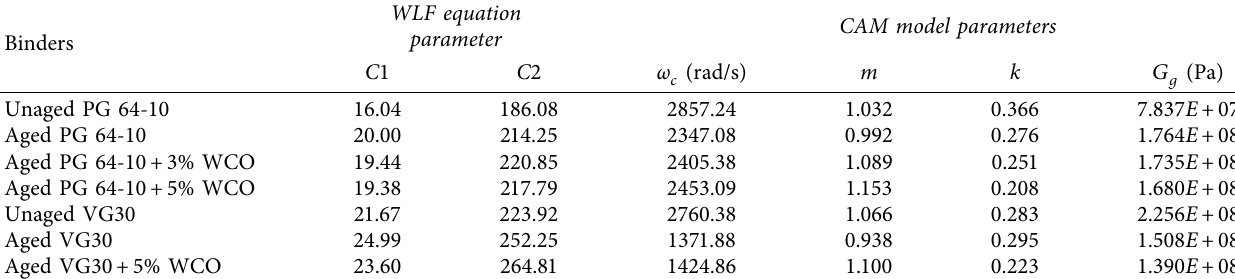
Table 2: WLF and CAM model parameters for master